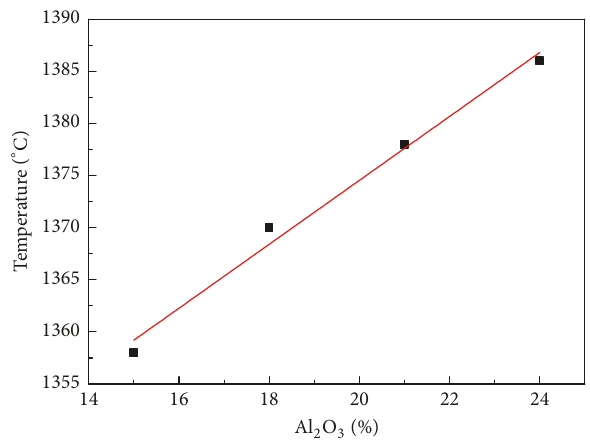
Figure 4: Effect of Al 2 O 3 content on break point